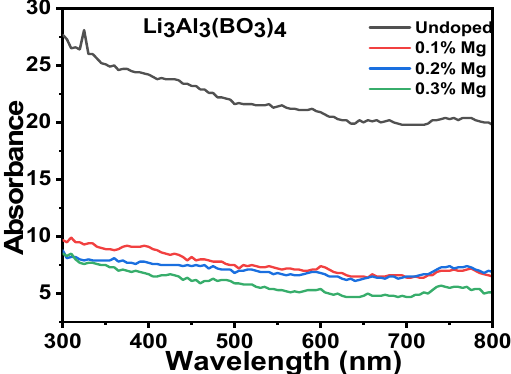
Figure 4. The optical absorbance plots versus the wavelength for the undoped concentrations and various concentrations of magnesium ‐ doped lithium aluminium borate.